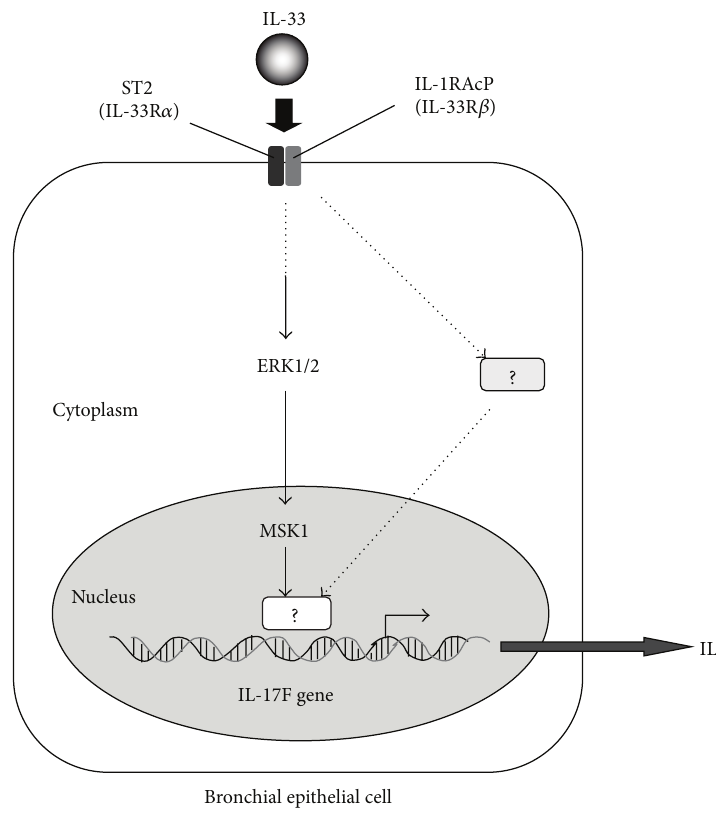
Figure 3: Signaling mechanism of IL-17F expression in bronchial epithelial cells. Bronchial epithelial cells are a novel cell source of IL-17F. The expression of IL-17F is induced by IL-33. IL-33 binds to its receptor, ST2, and then the ERK1/2-MSK1 signaling pathway is activated. However, other stimuli inducing IL-17F and their signaling pathways are largely